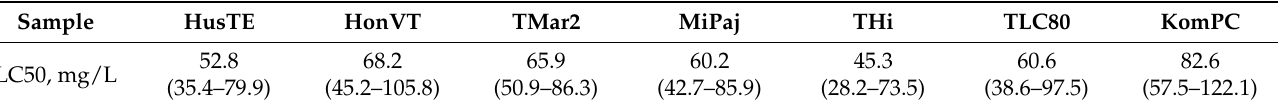
Table 5. Mean calculated LC50 values of embryo mortality of the sea urchin S. intermedius after 24 h of exposure to the VEPs. Sample